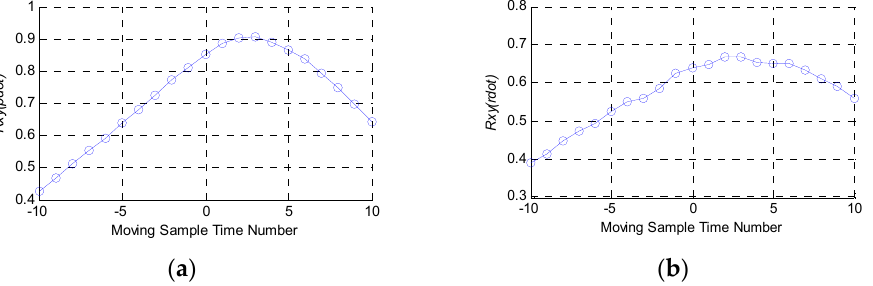
Figure 5. Cross-correlation function values of AAR of AVEM and differential signals of angular velocity data. ( a ) Roll angular velocity; ( b ) Yaw angular velocity. Table 2. Iteration results of unknown parameters in generic aerodynamic moment model.